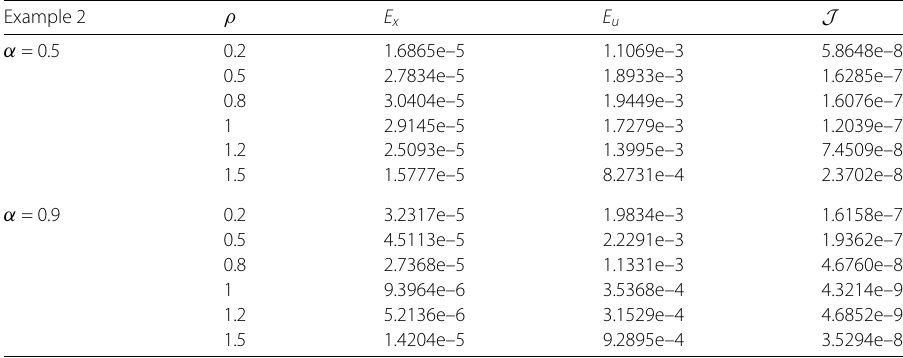
Table 7 The maximum absolute errors E x and E u at N = 5 and various values of α , ρ for x ( t ) and u ( t ), respectively Example 2 ρ E x E u J α = 0.5